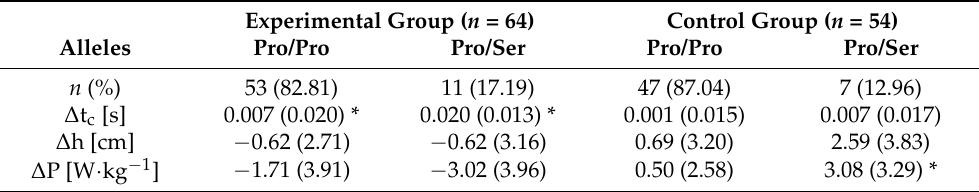
Table 4. Effect of HIF1A gene on supercompensation effect in CJ10.